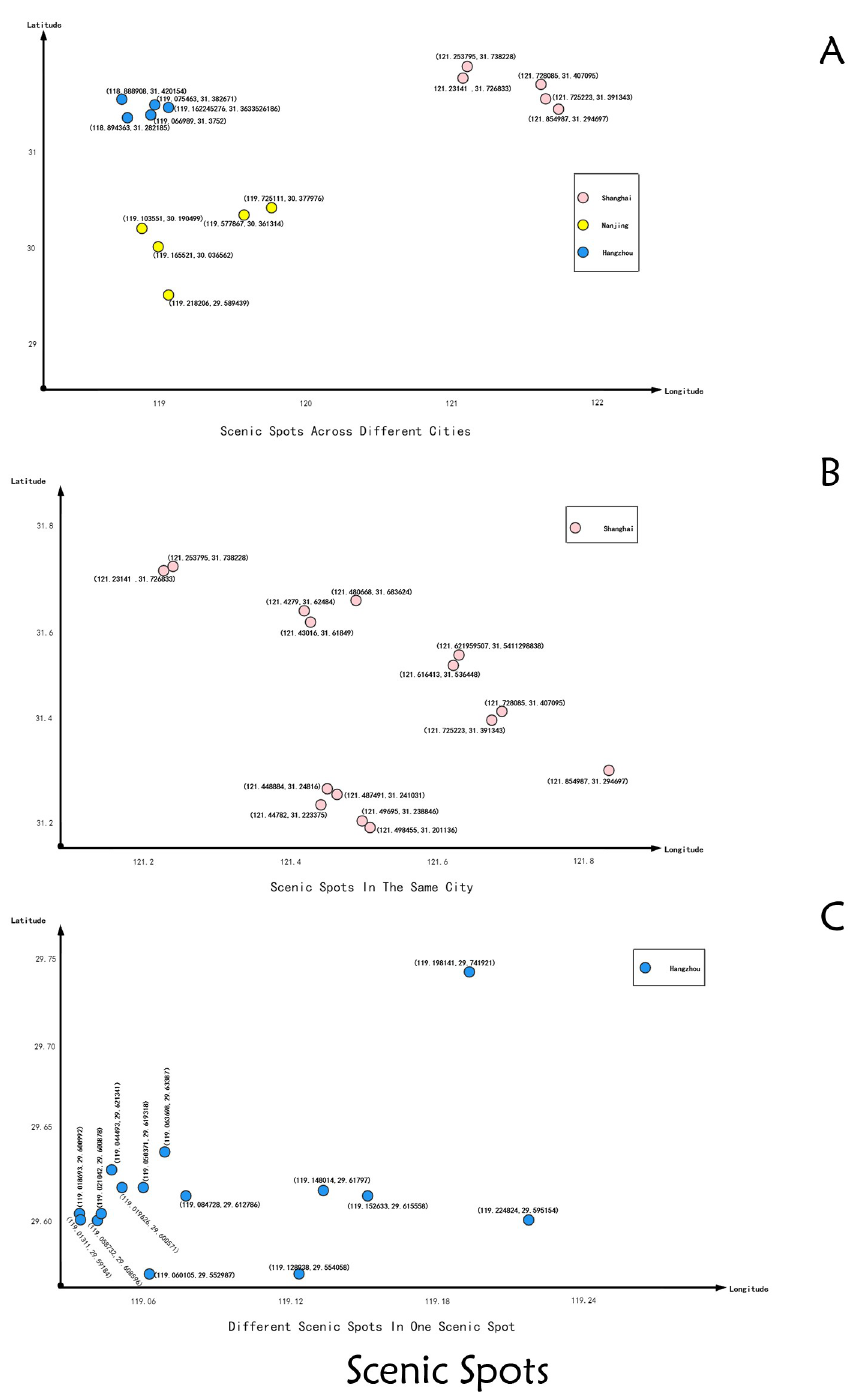
Fig 2. Scenic spots. A: scenic spots across different cities, including 15 scenic spots in Shanghai, Hangzhou and Nanjing of China. B: scenic spots in the same city, including 15 scenic spots in Shanghai. C: different scenic spots in one scenic spot, we take 15 scenic spots of Qiandao